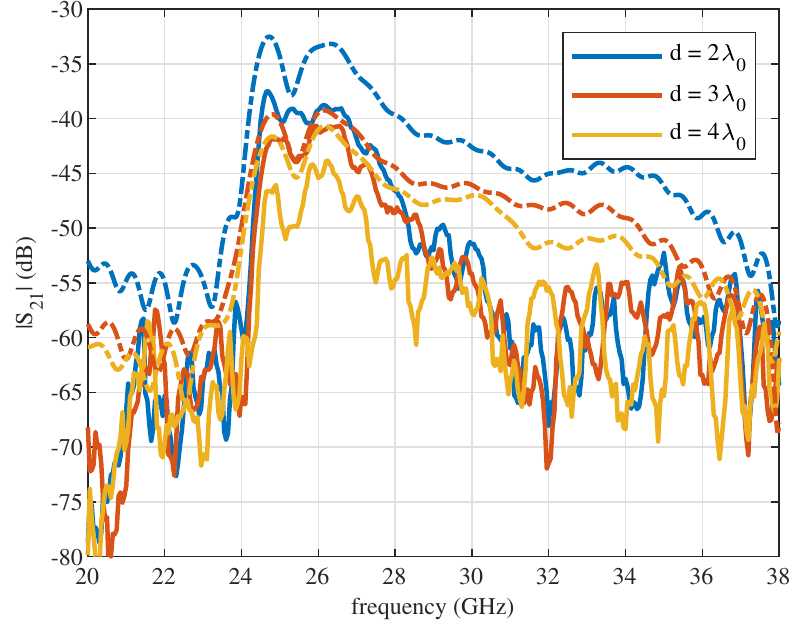
Figure 13. Measured (continuous lines) and simulated (dotted lines) S 21 coefficient for different values of the inter-element spacing d show that the coupling at 28.5 GHz is